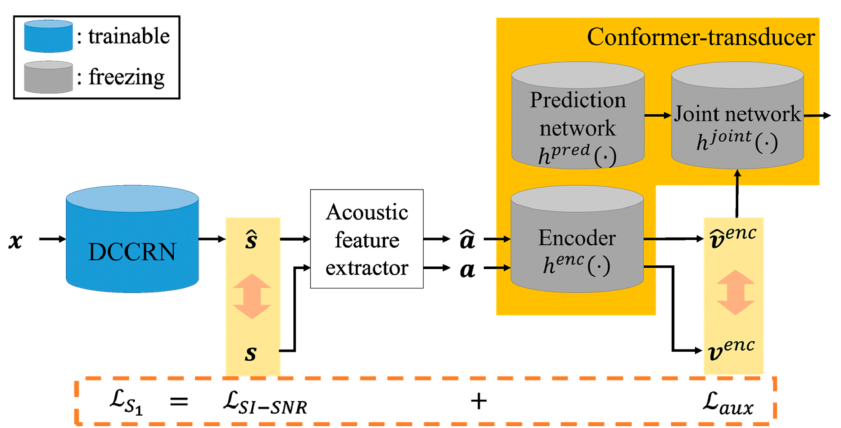
Figure 4. Block diagram of computing the first-step loss of the proposed two-step joint optimization